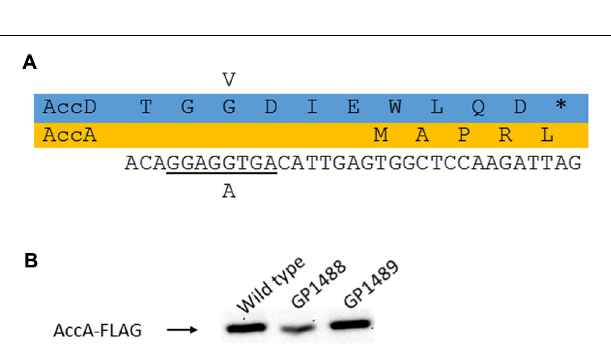
FIGURE 3 | Analysis of the AccD-G283V substitution. (A) Effect of the mutation on the accD coding region and the AccD protein as well as on the accA ribosome binding site. (B) Expression of AccA as a consequence of the altered ribosome binding site. To study AccA levels, the protein was fused to a FLAG